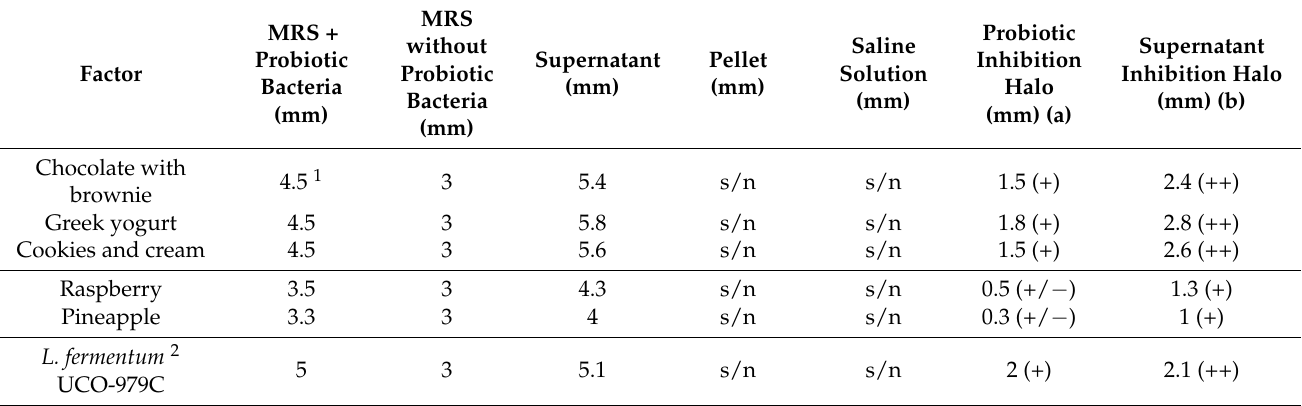
Table 2. In vitro anti- H. pylori activity of the probiotic strain L. fermentum UCO-979C in the different ice cream bases at 90 days of storage at − 18 ◦ C.